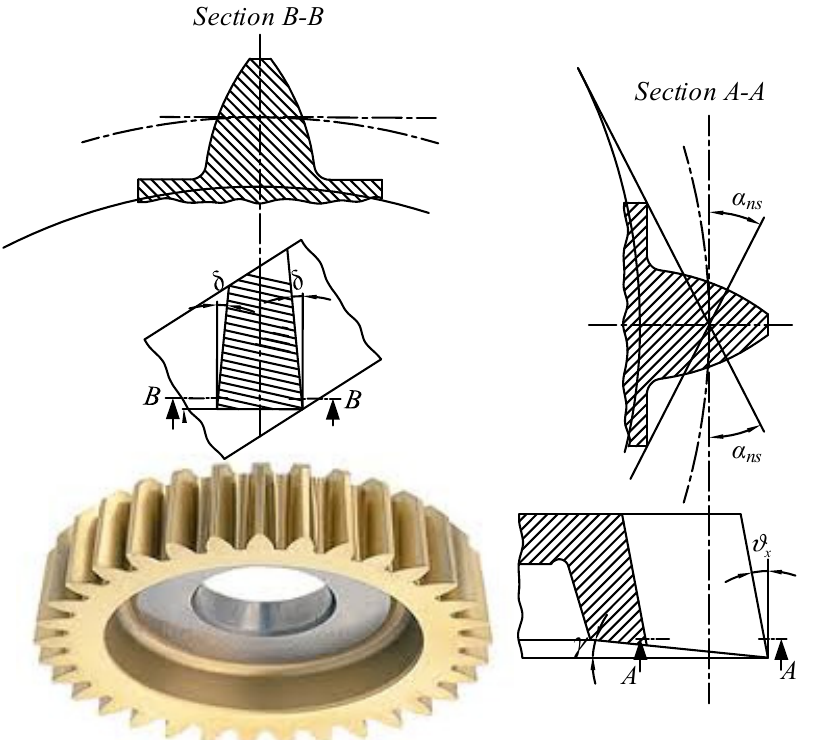
Figure 7. Cutting angles of a spur shaping cutter.